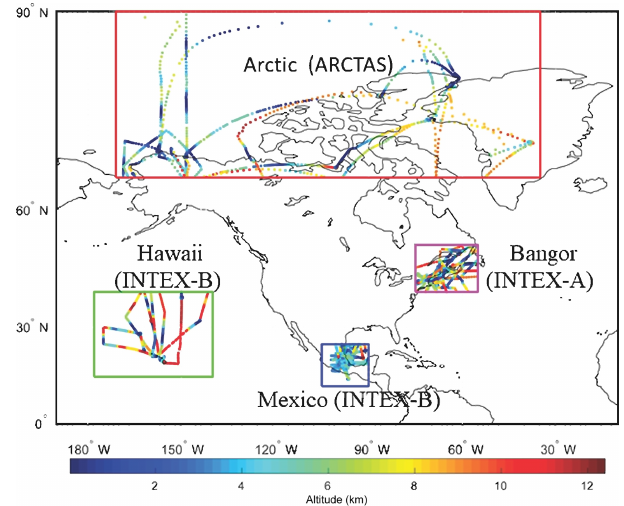
Figure 8. The location of the four selected regions. The red, green, blue and magenta rectangles show the Arctic (ARCTAS, ico (INTEX-B, March–May 2006) and Bangor (INTEX-A, July– August 2004),